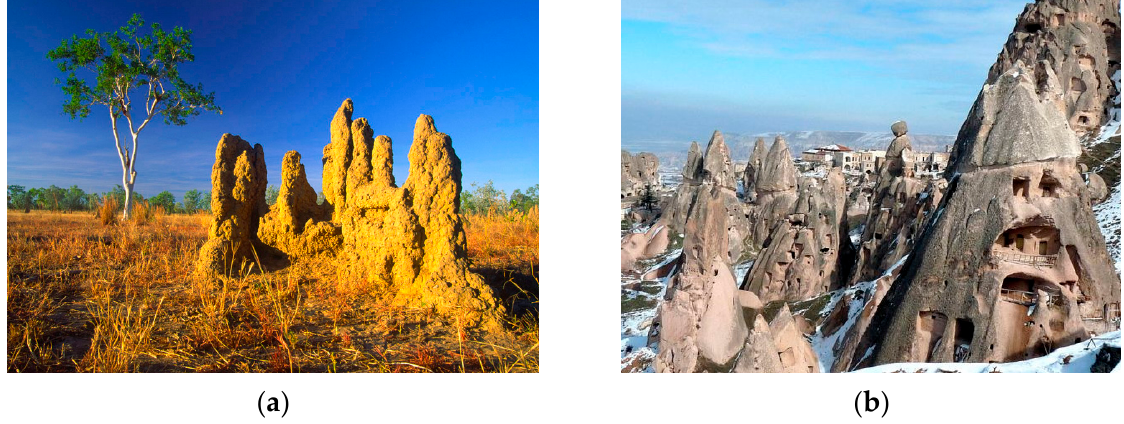
Figure 7. Comparison of the morphology of ( a ) the anthill and ( b ) the rock house in Cappadocia, Turkey.